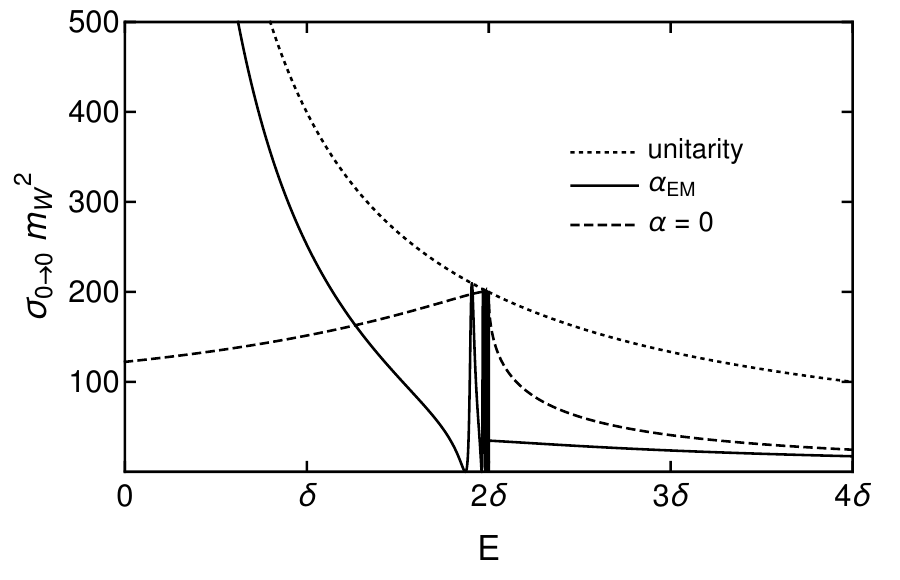
Figure 3 . The neutral-wino elastic cross section (cid:27) 0 ! 0 as a function of the energy E . The cross section for M = 2 : 39 TeV is shown for (cid:11) = 1 = 137 (solid curve) and for (cid:11) = 0 (dashed curve). The S-wave unitarity bound is shown as a dotted